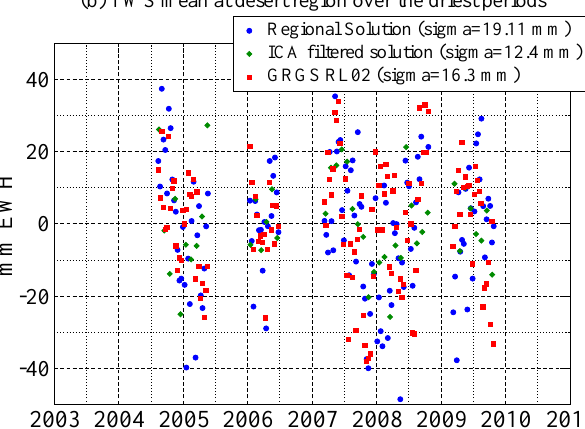
Fig. 5. Time series of TWS means over the estimated desert region (central Australia) of 18 tiles, the largest signal amplitudes are lesser than 30mm and the RMS value is of 19mm.